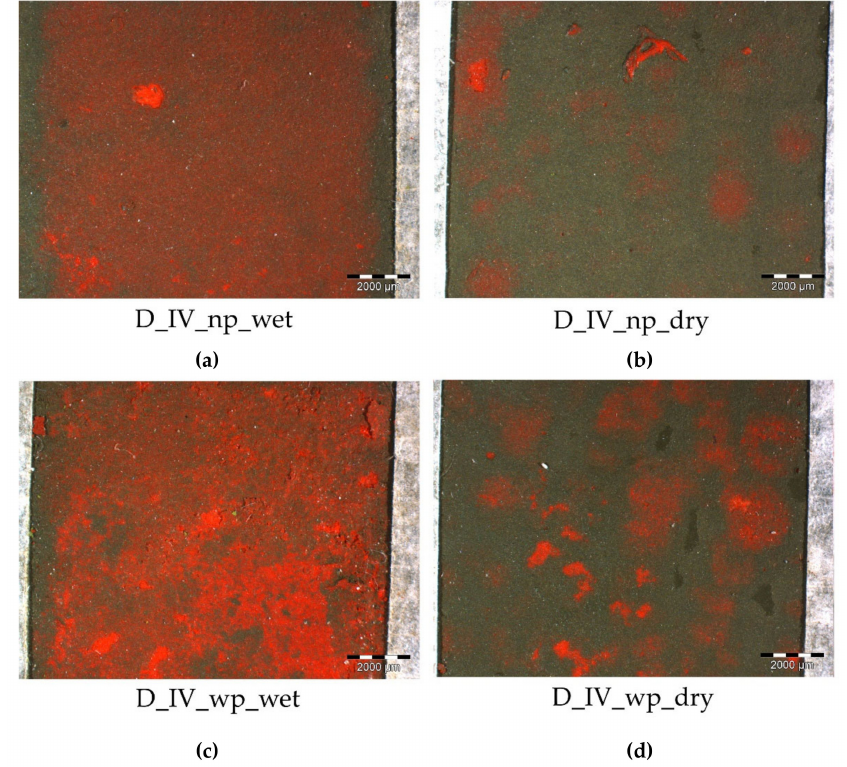
Figure 14. Optical images at 10 × magnification of mock-up D treated with laser at 7 Hz frequency and fluence of 4.14 J / cm 2 on wet surfaces ( a , c ) and 6 Hz frequency and fluence of 4.14 J / cm 2 on dry surfaces ( b , d ), both on unprotected (np) and protected (wp) areas. ( a ) D_IV_np_wet; ( b ) D_IV_np_dry; ( c ) D_IV_wp_wet; ( d )